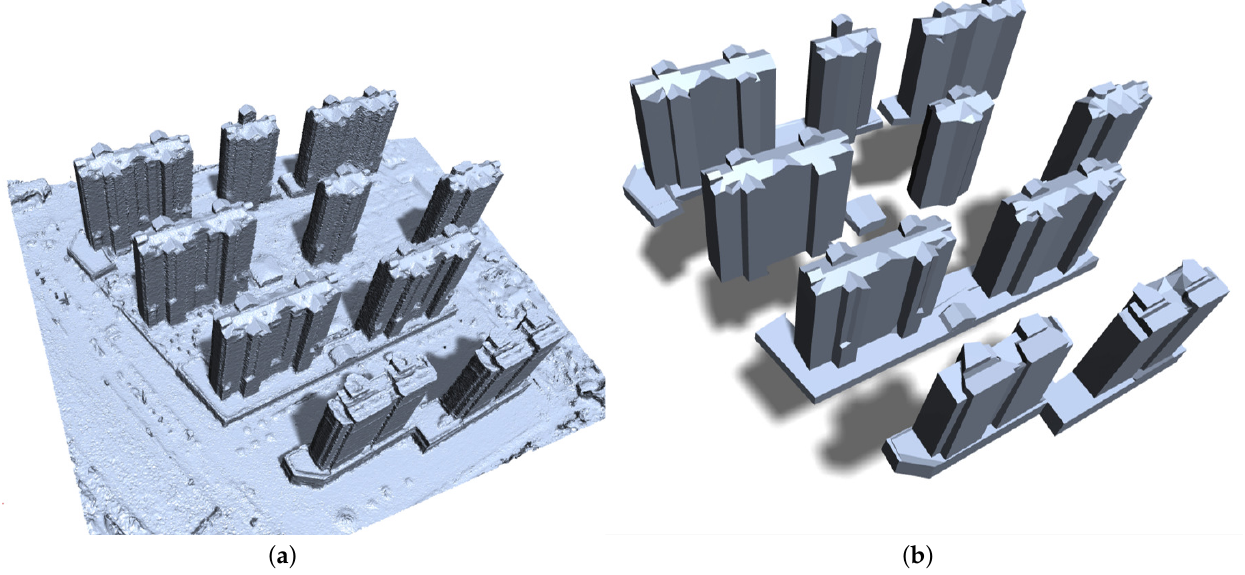
Figure 15. Application of our technique for building-mesh polygonization on Nanyang data: ( a ) Orig- inal and ( b ) Our building-mesh polygonization